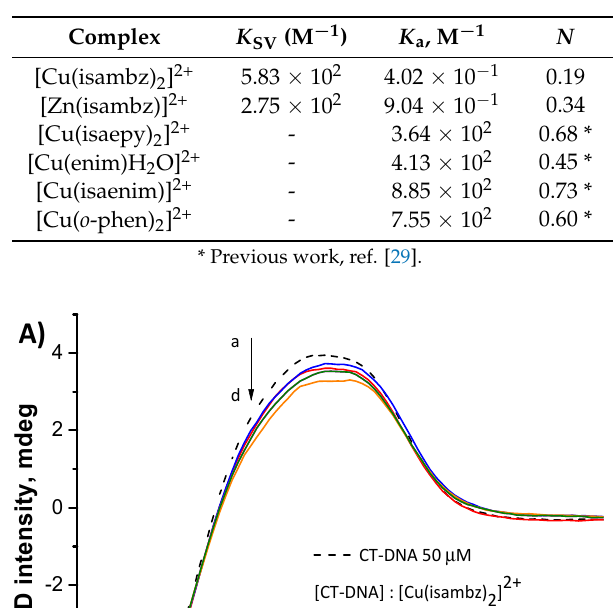
Table 1. The quenching constants and binding site number of CT-DNA/EtBr or plasmidial DNA/EtBr* by some Schiff base–copper(II) or zinc(II) complexes.